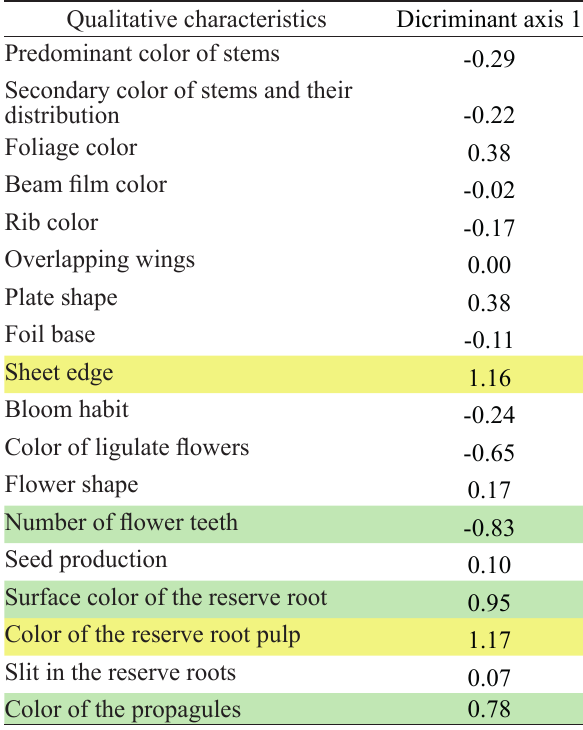
Table 2: Phenotypic characteristics that discriminate four phenotypic groups of the 34 yacon samples ( S. sonchifolius ) in the province of